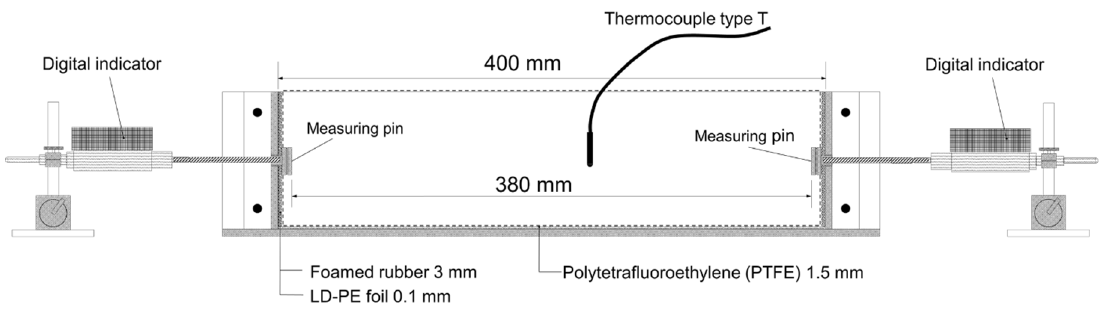
Figure 5. Experimental set ‐ up for measuring autogenous deformation [11]. The end plates of each mould had holes bored in the centre for the insertion of deformation measurement pins. Linear